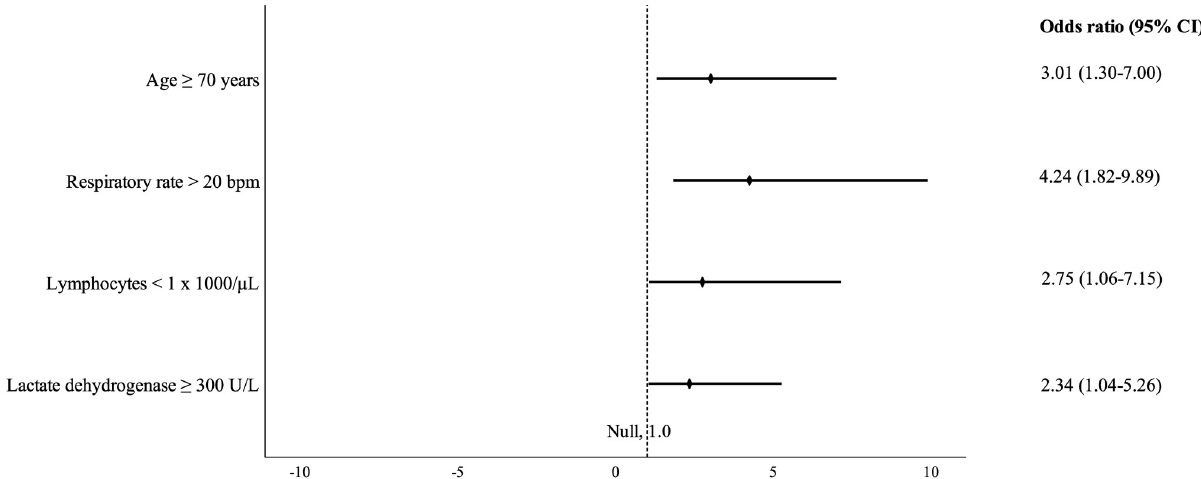
Fig 2. Independent baseline predictors of unfavorable